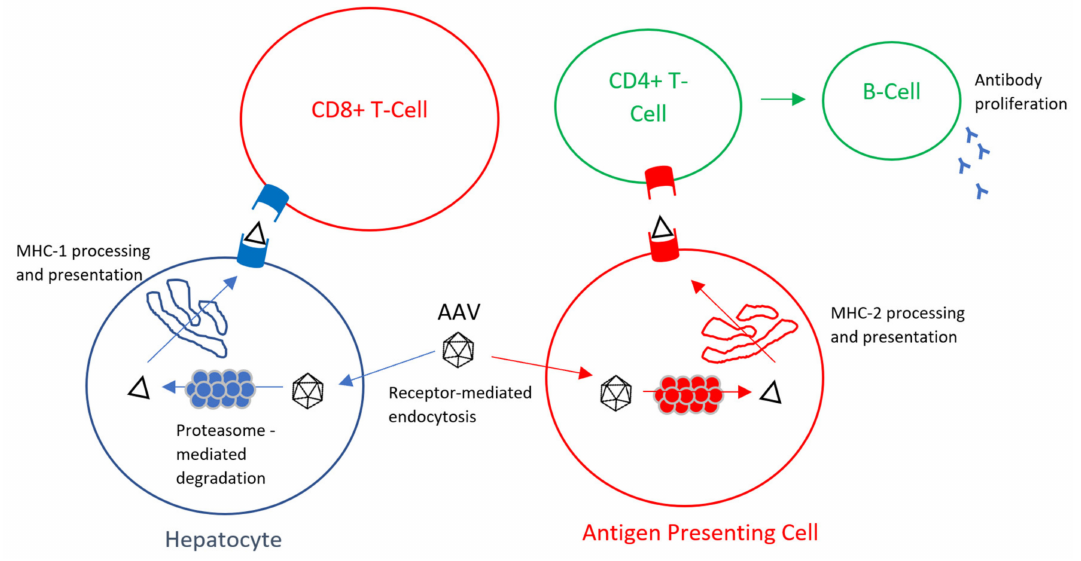
Figure 1. Mechanism of AAV CD8 + cytotoxic immune response and CD4 + humoral immune response